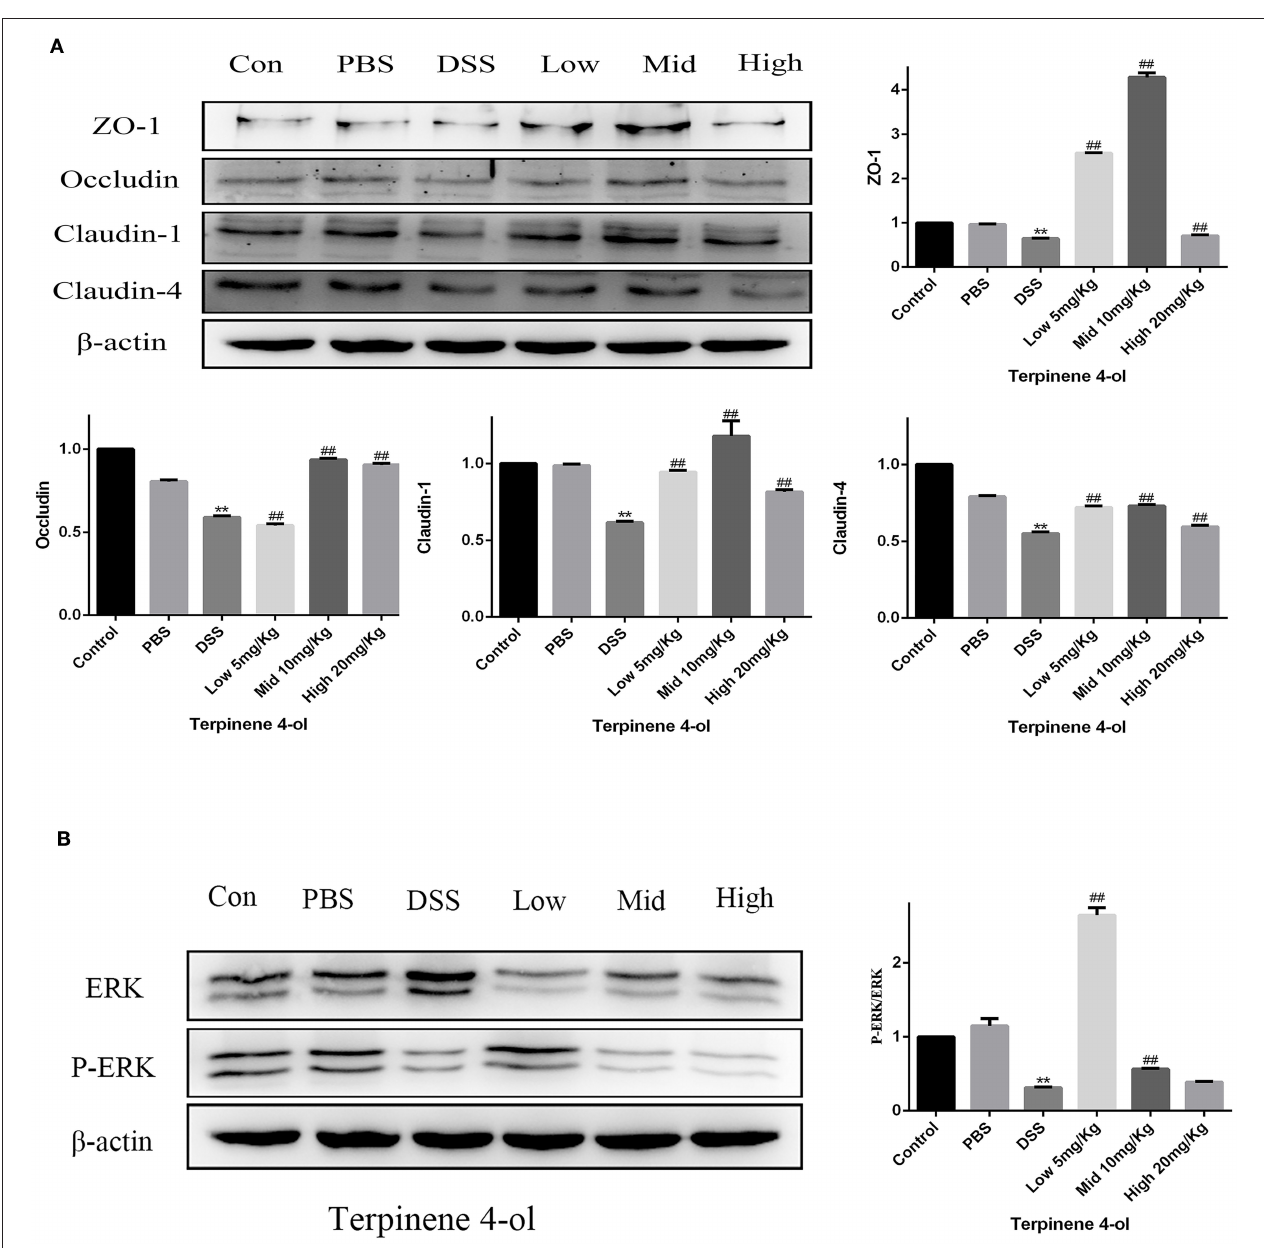
FIGURE 9 | Effect of terpinen-4-ol (TER) on the tight junction (TJ) and ERK-pathway protein expression in mice. (A) Expression of colon TJ proteins and (B) ERK-signaling proteins in mice after drinking DSS solution. ** and ## display similar means with above